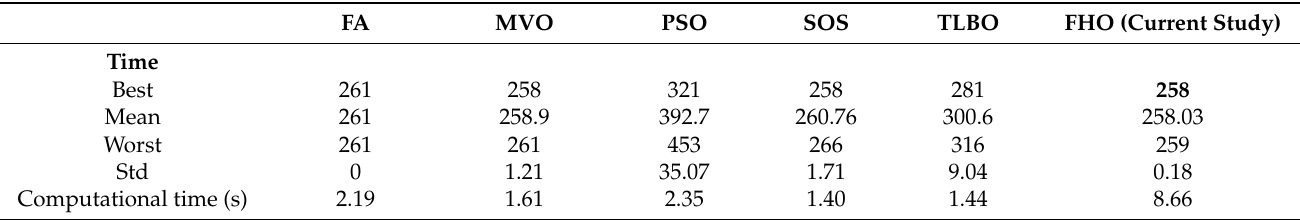
Table 3. The statistical outcomes of the